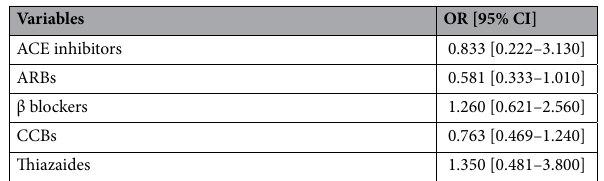
Table 4. Sub-analysis; ORs of each antihypertensive drugs for delirium. The ORs of each kinds of antihypertensive drugs for incidence of delirium were evaluated. † The results were considered statistically significant based on 95% CI. ACE Angiotensin-converting enzyme, ARB Angiotensin II receptor blocker, CCB Calcium channel blocker, CI Confidence interval, OR Odds ratio.